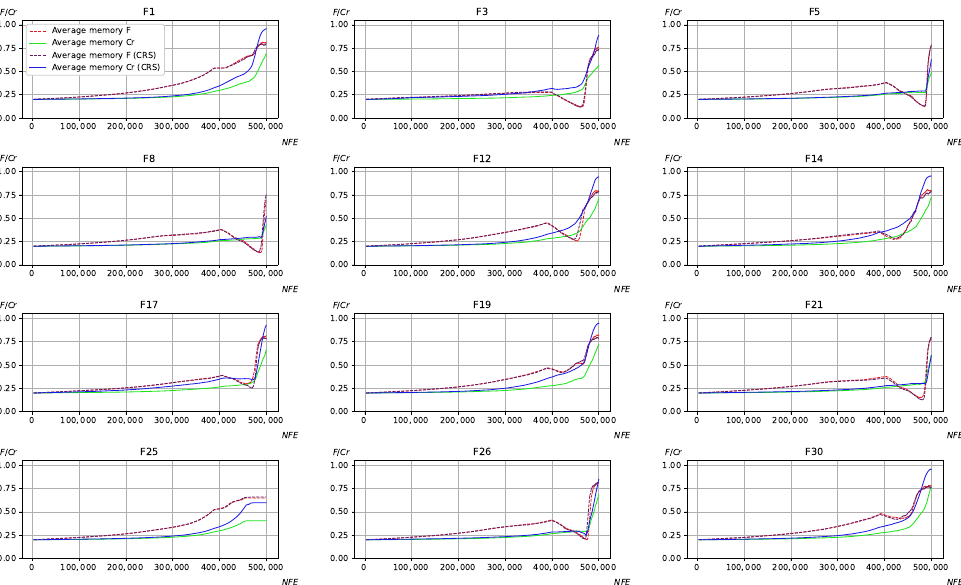
Figure 4. Parameter adaptation with and without crossover rate sorting, NL-SHADE-RSP, CEC 2017, 50 ∗ D